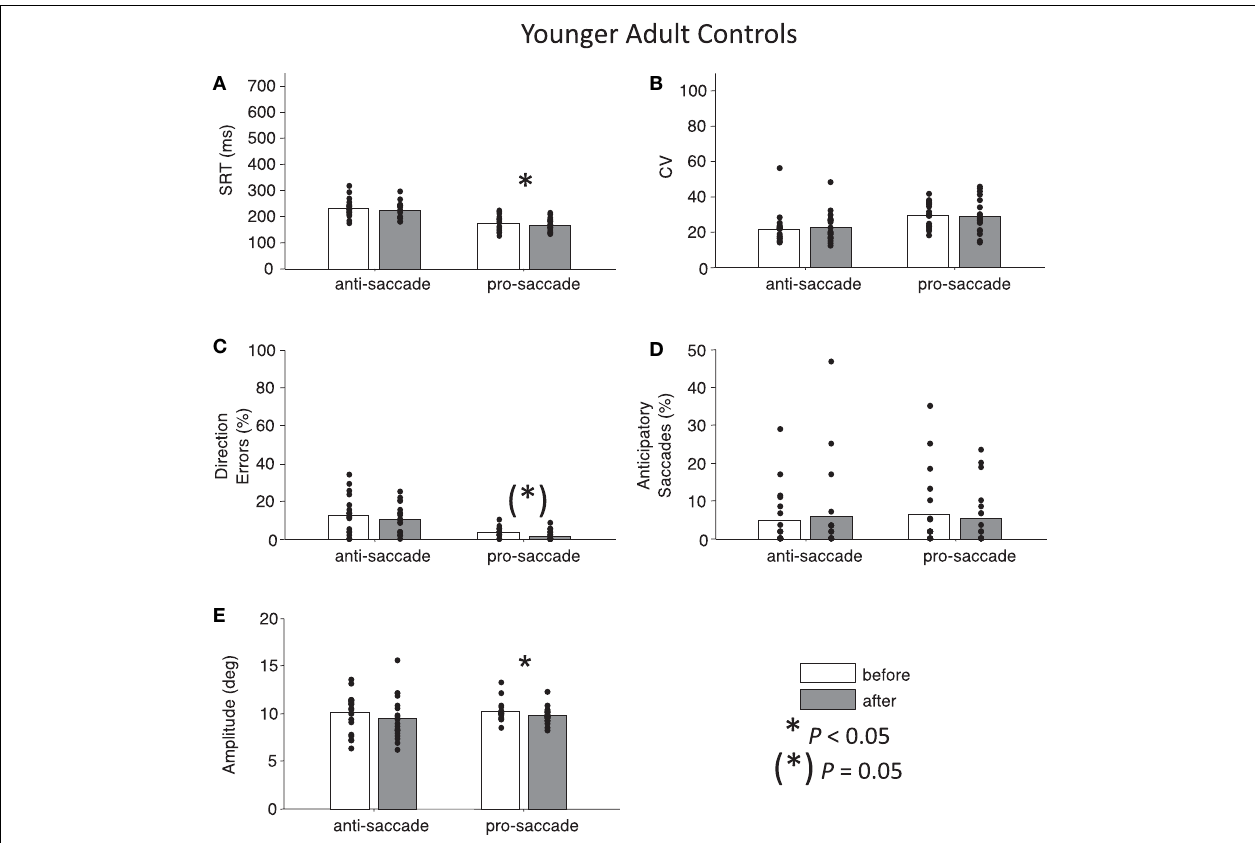
FIGURE 6 |Anti- and pro-saccade behavior in healthy younger adults. (A) Saccade reaction time (SRT). (B) Intra-subject coefficient of variability in saccade reaction time (CV). (C) Percentage direction errors. (D) Percentage anticipatory saccades. (E) Saccade amplitude.